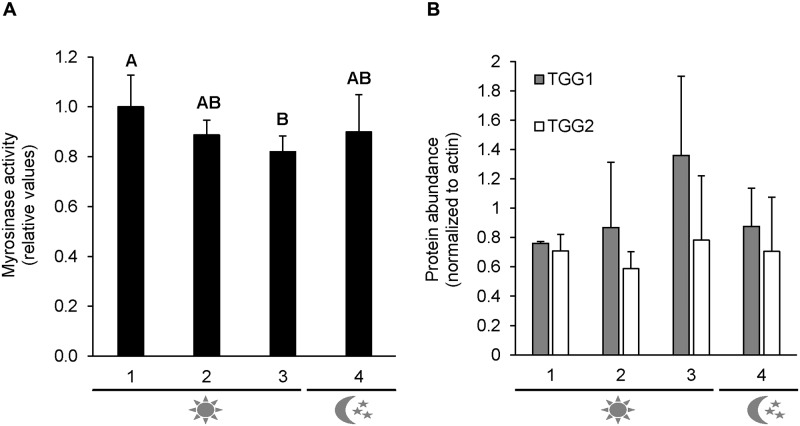
Diurnal myrosinase activity and protein abundance in two-week-old A. thaliana plants grown under long-day conditions.The plants were harvested at four different time points: 1 Beginning of the light period; 2 Middle of the day; 3 End of the light period; 4 Middle of the night. The myrosinase activity (A) was measured photometrically and normalized to the maximal activity. Error bars show the standard deviation of four to five biological replicates (pools). For protein abundance of TGG1 and TGG2 (B), immunoblotting and normalization with actin was performed. Error bars represent the standard deviation of three independent experiments with one pool of plants. Significantly different means are indicated by different letters (Student Newman Keuls; P < 0.05).